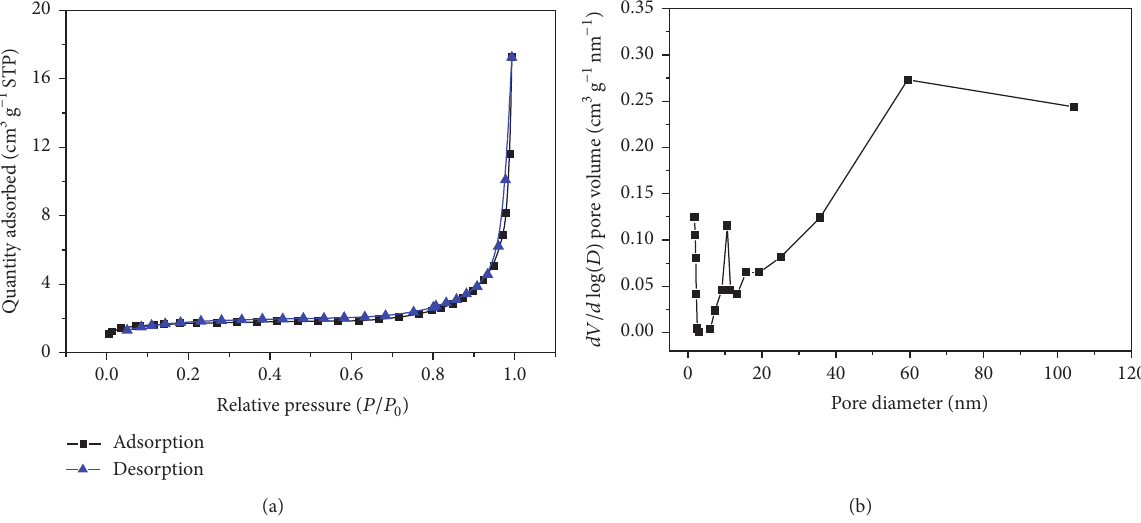
Figure 4: (a) Nitrogen adsorption-desorption isotherm and (b) pore size distribution curve of the porous ZnO